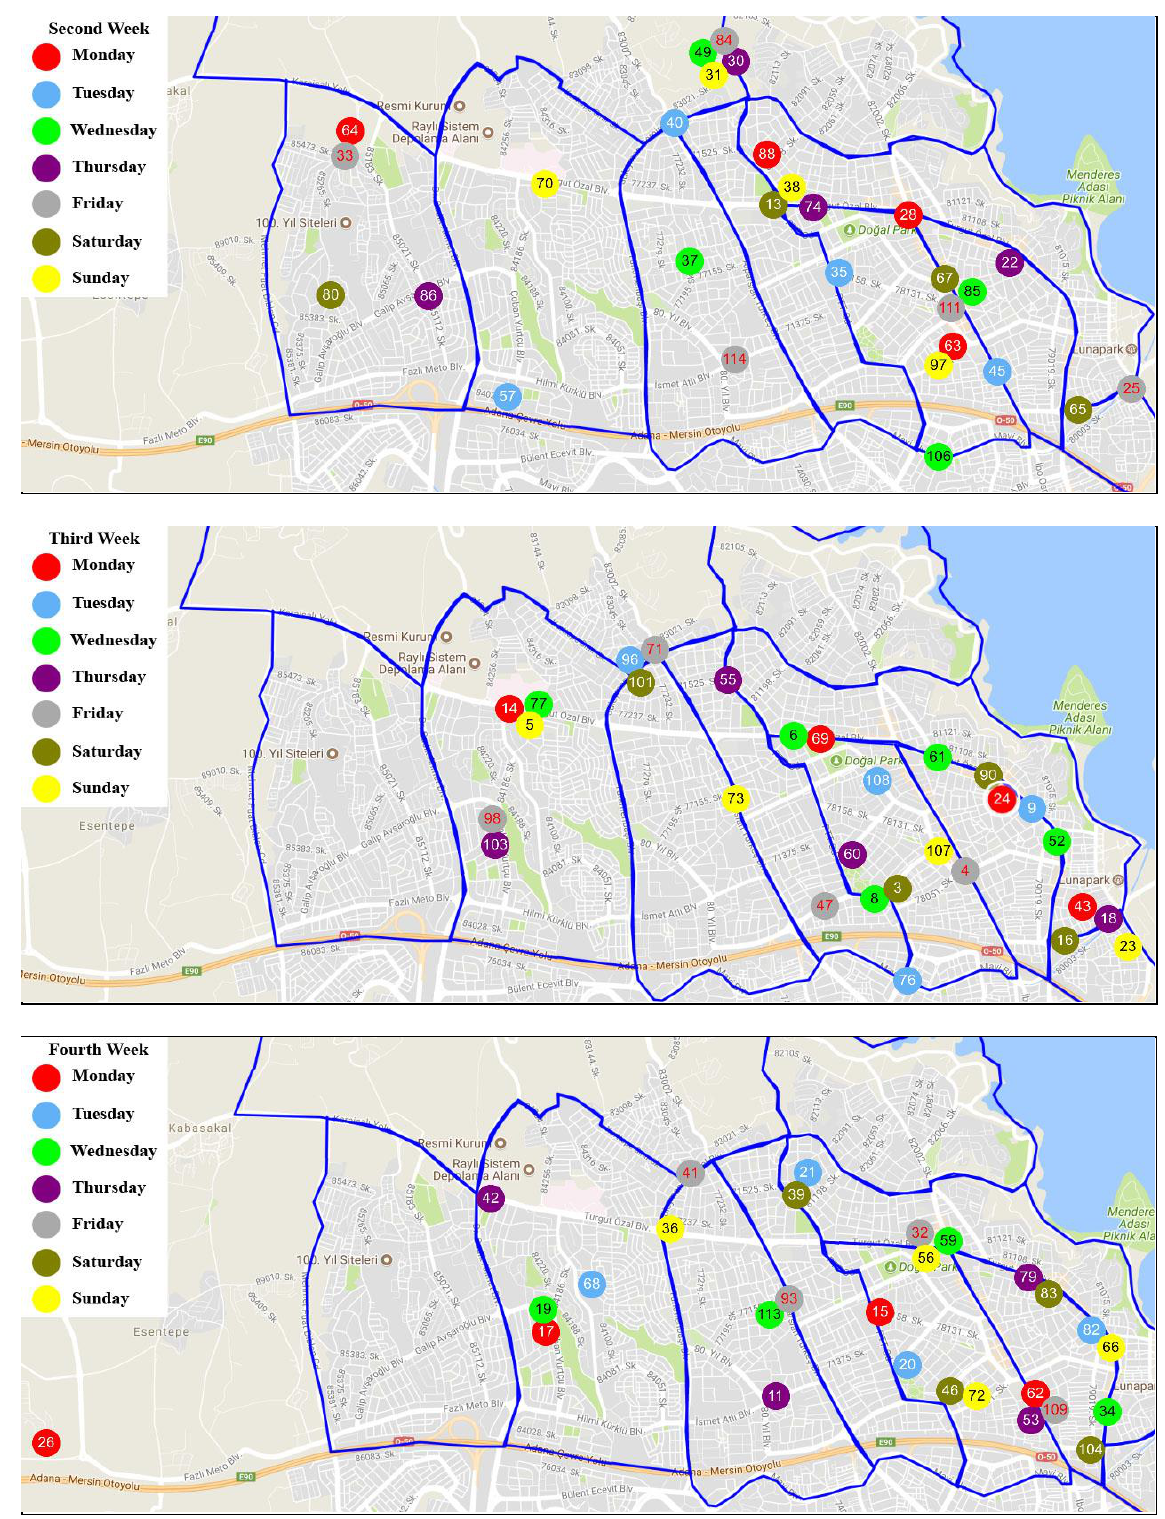
Figure 2. Duty pharmacies on each week in 28 days